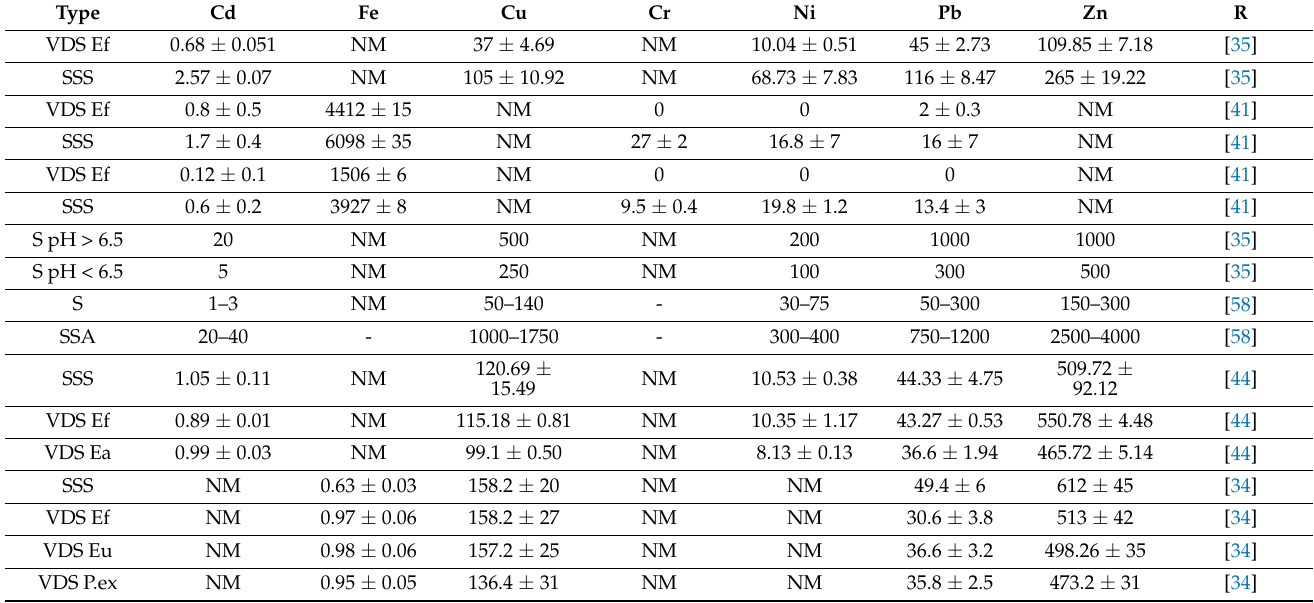
Table 3. Values of metal content in the vermicomposted sludge and in the initial substrate (unit: mg/kg dry matter) (data from [34,35,41,44,58]).